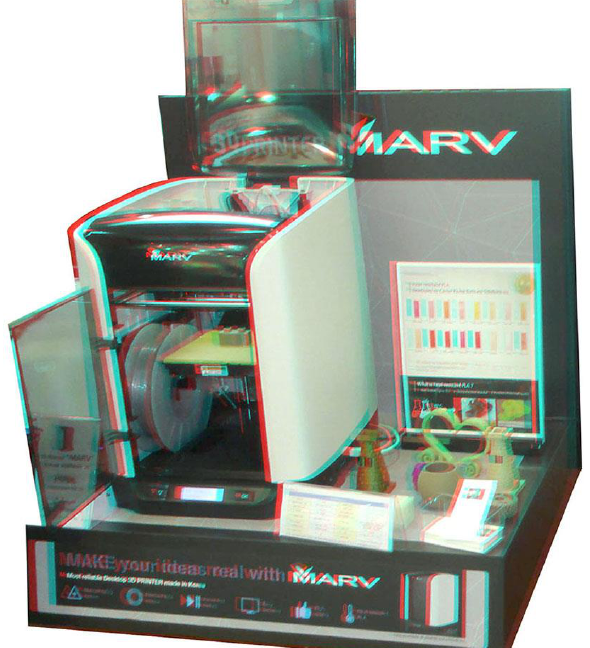
Figure 11. 3D printer (Real models also belong to the principles Figure 14. Comparison of a 3D photography of the original, a of 3D visualization) laser crystal version and 3D print of the world eldest (Courtesy MARV (South Korea), 3D photograph: Schuhr) observatory